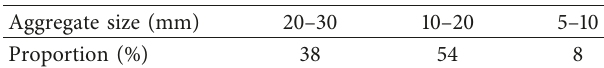
Table 2: Composition of coarse aggregate for cement concrete.